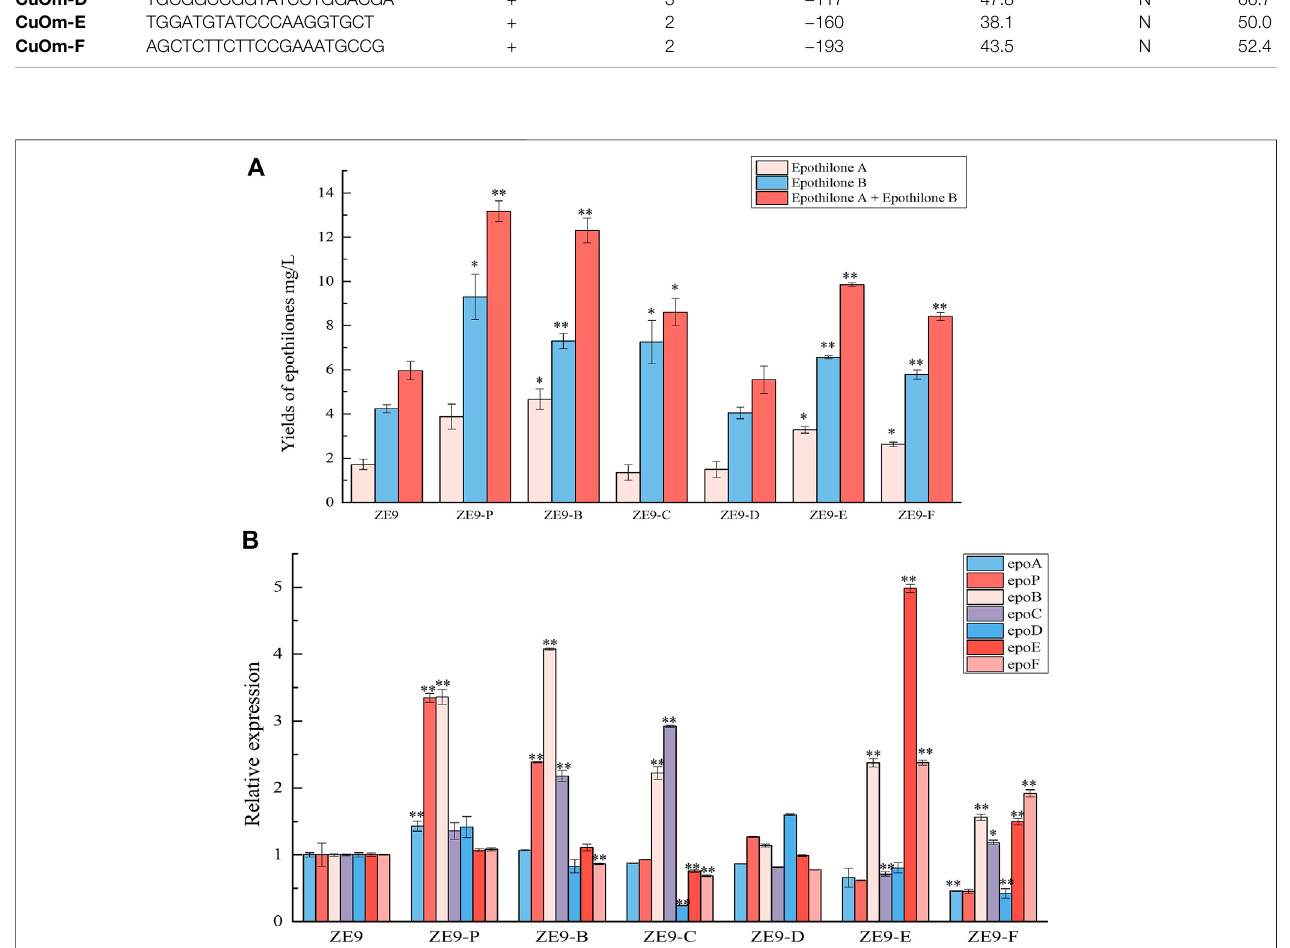
FIGURE 3 | CRISPRa of internal promoters in the epothilone operon. (A) Yields of epothilones A and B and their summation in different activation mutants and M. xanthus ZE9. (B) RT-qPCRanalysisofexpression levels of theseven operon genes in different mutants and M. xanthus ZE9 after 48 h ofincubation. The expressions of theoperongenesin M.xanthus ZE9wereeachsetas1,andtheexpressionsofthegenesinmutantstrainsareshownastherelativeexpression.Theerrorbarsrepresent the standard deviation of three independent experiments. For statistical analysis between the ancestral strain and mutant strains, the signals of ** and * mean p < 0.01 and p < 0.05,